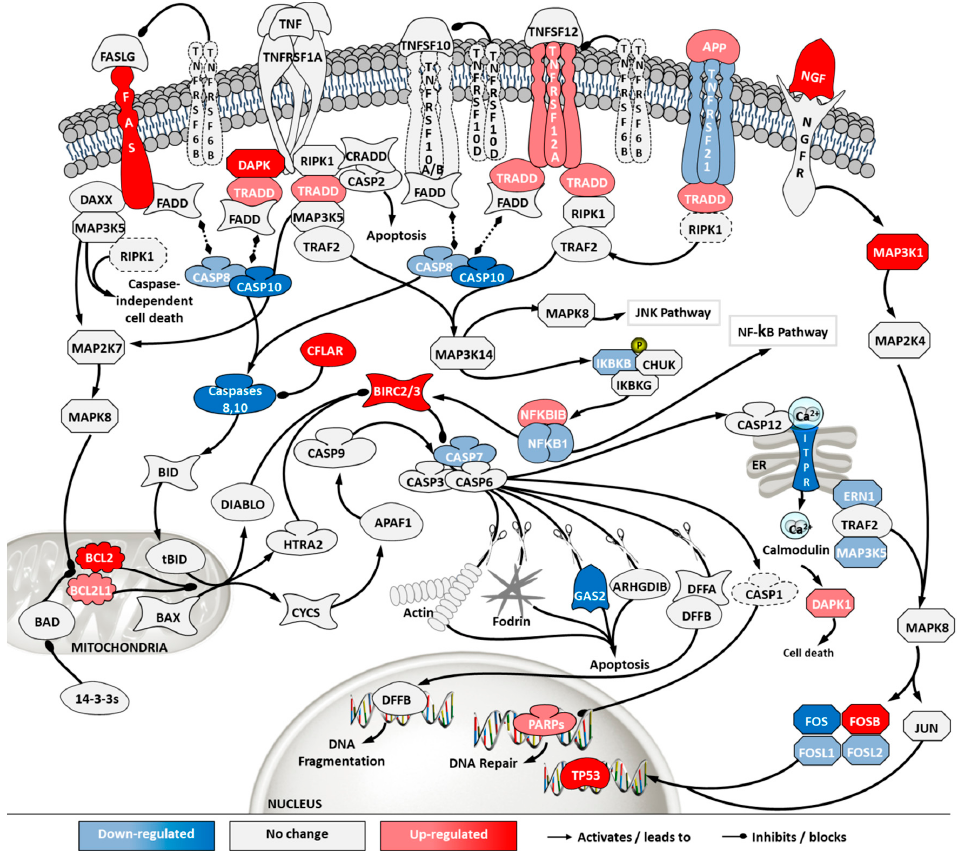
Figure 7. Differential gene expression in apoptosis and death receptor signaling pathway in ‘ECACC vs. ATCC’ cells. Differential expression patterns for pairwise comparison of ‘ECACC vs. ATCC cells’ matching culture conditions and infection status. Differential expression values of 2-fold occurring in, at least one, of the pairwise comparisons are indicated in dark red and dark blue. Since pathway analysis is based on orchestrated changes, even if small, more modest expression changes (between 1.5-fold and 2-fold) are also showing in light red (up-regulation) and light blue (down-regulation), although these modest changes were not used as a differential expression cut-off for running pathway analysis. Dashed genes indicated genes for which no probes were found in the array. Map downloaded from PathwayCentral(SABiosciences, nowpartofQiagen)andmanuallycuratedandadapted. Absolutegene expression values and gene expression fold-change for each gene are given in Supplementary File 3. For a matter of simplicity, only gene symbols are shown: the o ffi cial full name of each gene was omitted and can be found in Supplementary File